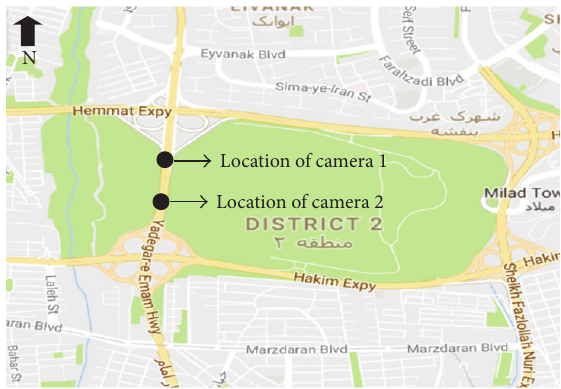
Figure 3: The location of speed